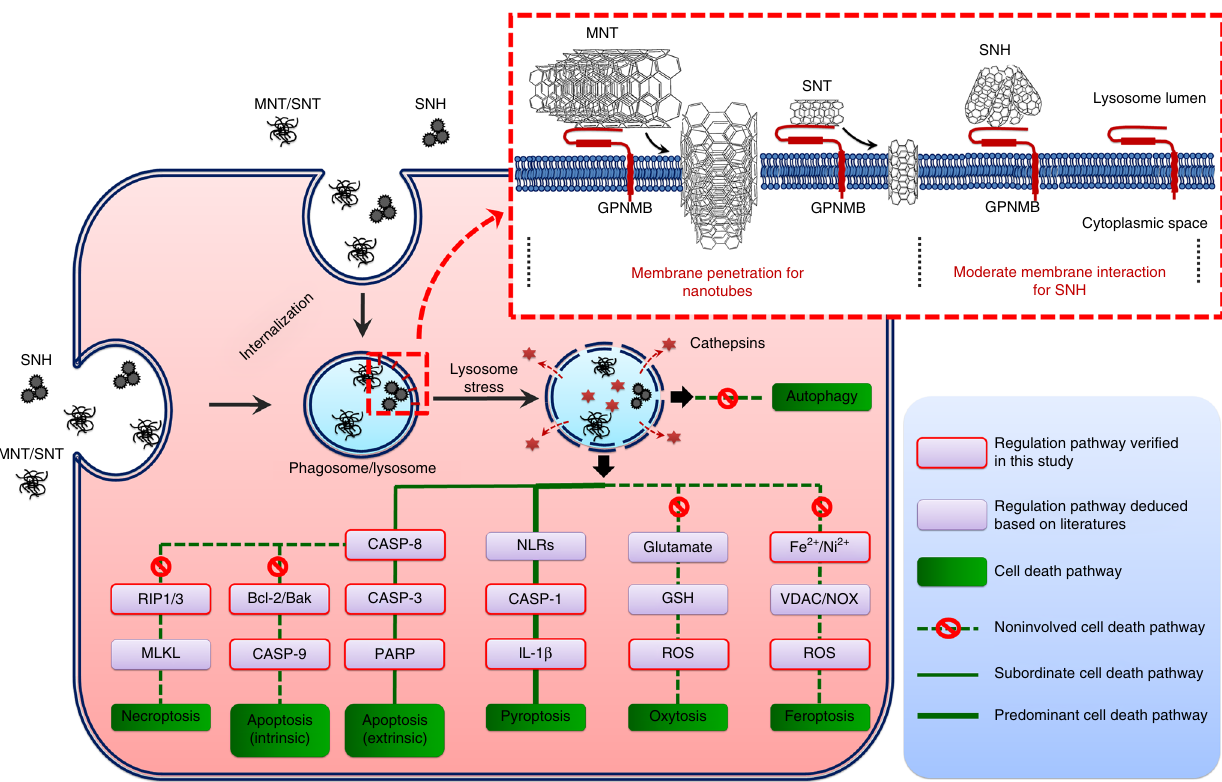
Fig. 10 Schematic of cell death mechanisms induced by SNH and CNT. Nanocarbons interacted with test cells in assemblies and internalized through phagocytosis pathway. GPNMB was found with high af fi nity to nanocarbons, which strengthened the nano-membrane interaction, initiated lysosome stress, induced the leakage of hydrolases, triggered the activation of pyroptosis and extrinsic apoptosis pathways, and fi nally led to the death of macrophages. Distinctively, the less cellular uptake, lower nano-protein interaction, and moderate membrane disturbance endowed SNH with hypotoxicity, predicting a promising future for the potential biomedical applications for SNH. SNH single-walled carbon nanohorns, MNT multiple-walled carbon nanotubes, SNT single-walled carbon nanotubes, GPNMB glycoprotein nonmetastatic melanoma protein B, CASP-1/3/8/9 caspase-1/3/8/9, NLRs Nod-like receptors, RIP1/3 receptor-interacting protein kinase 1/3, Bcl-2 B cell lymphoma ‑ 2, Bak apoptosis regulator BAK, PARP poly (ADP-ribose) polymerase, MLKL mixed lineage kinase domain-like, GSH glutathione, ROS reactive oxygen species, VDAC mitochondrial voltage-dependent anion channel, NOX NADPH